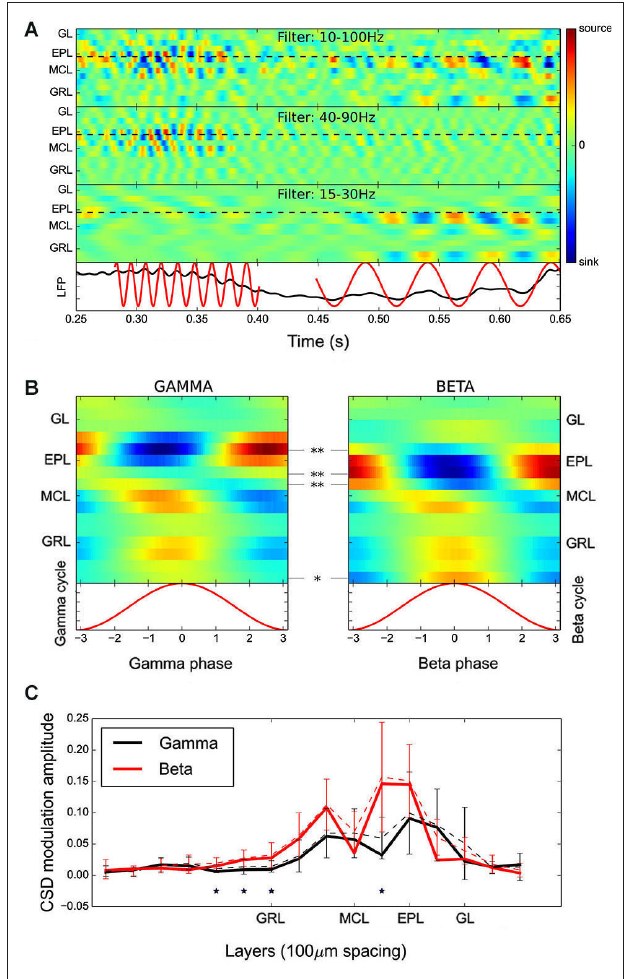
FIGURE 2 | CSD analyses of fast rhythms revealed that different sub-layers of the OB network are involved in beta and gamma oscillation generation. (A) Time evolution of the CSD for a single multielectrode recording filtered in three different frequency bands (from top to bottom: 10–100 Hz, 40–90 Hz, and 15–30 Hz). The plotted time represents a single respiratory cycle. Below is the raw signal recorded from the deepest electrode in the GRL, on which are superimposed the detected gamma and beta oscillations. Visual comparison of the different CSD maps (use the black dashed lines as a guide) shows that the major current sources and sinks during beta and gamma oscillations appear at different layers, spaced by one to two electrodes, i.e., 50–100 µ m. (B) Time evolution of the group average CSD maps across the gamma (left) and beta (right) cycles. Statistical significances are given as an electrode-by-electrode CSD amplitude comparison (range of recording sites averaged per electrode: N = 9–18). The current sink in the EPL was present in more superficial layers during the gamma oscillation. (C) Average amplitude of sink/source oscillation at each electrode during gamma (black) and beta (red) oscillations (error bars indicate the standard deviations). These data were obtained with electrodes spaced at 100- µ m intervals. The results confirm the spatial shift between gamma and beta current sources/sinks observed in ( A and B ) and additionally show that the beta oscillation is involved in a larger zone of the GRL. Statistical significances are assessed as in (B) . Note that the solid line corresponds to the amplitude of the group CSD modulation and the dashed line is the average of individual CSD amplitude modulation, on which statistical testing was